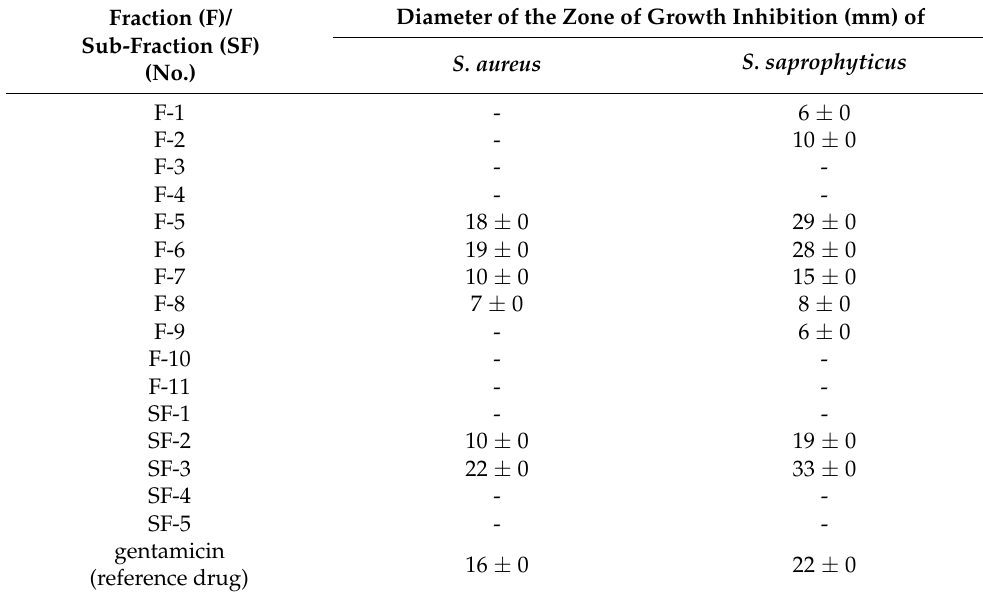
Table 3. Antimicrobial activity of the different fractions (F) obtained by silica gel column chromatog- raphy of the DCM extract of P. zeylanicus and sub-fractions (SF) obtained from the combined fraction F-5 + F-6. The diameter of the zone of bacterial growth inhibition is given as means ± S.D, n = 2. Diameter of the Zone of Growth Inhibition (mm) of Fraction (F)/ Sub-Fraction (SF) S. (No.)